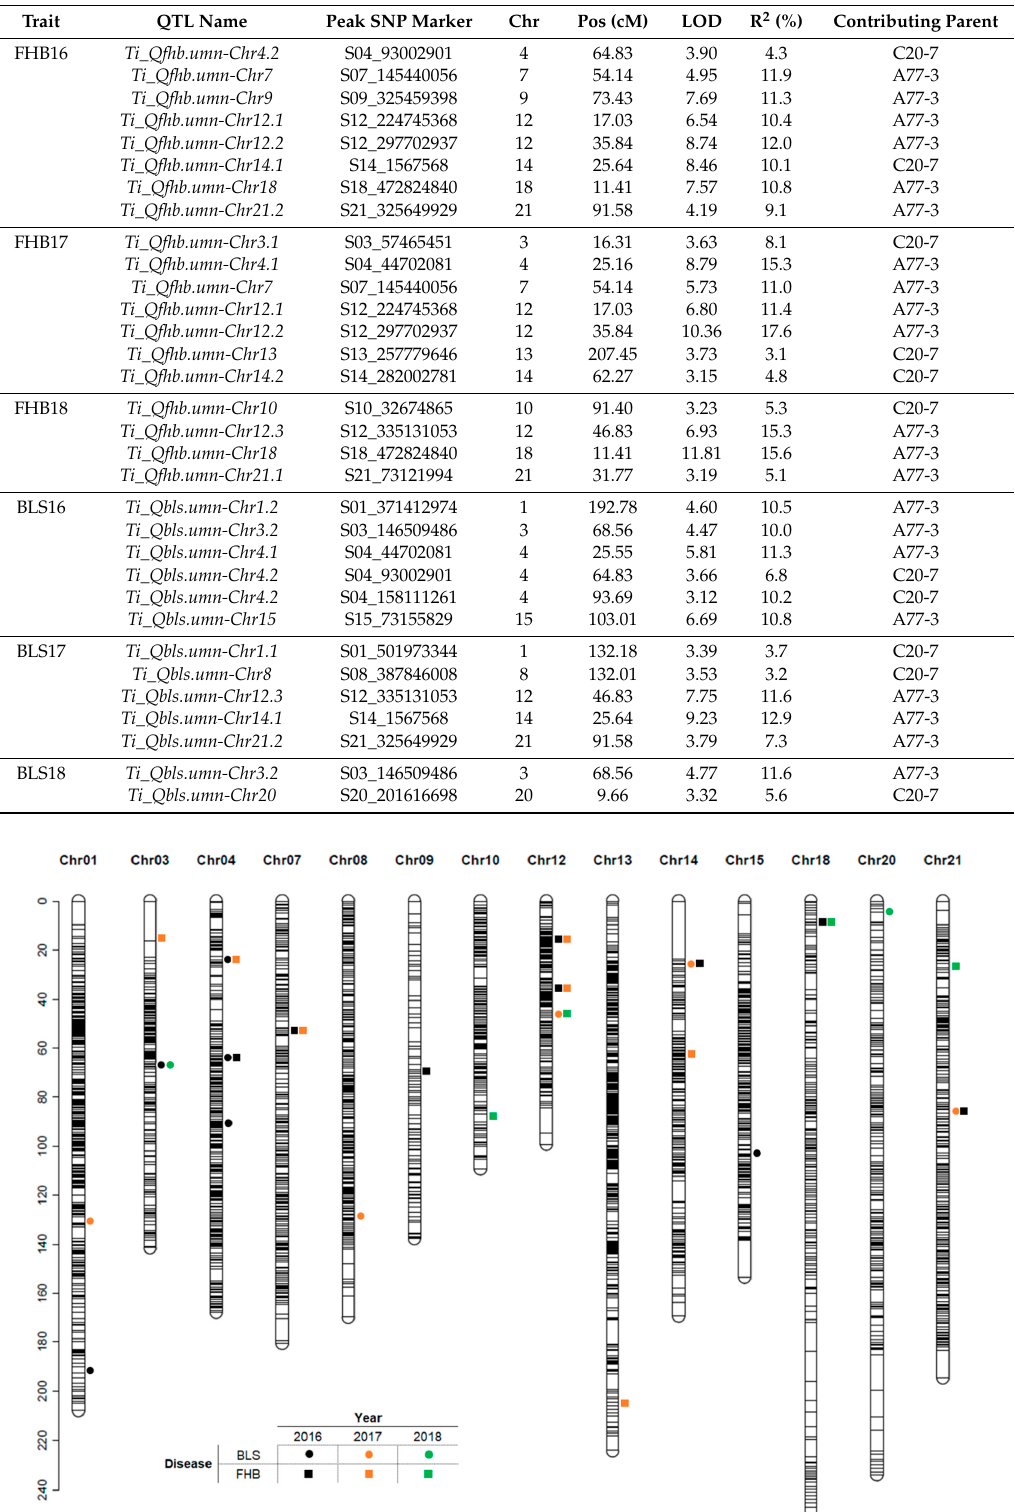
Table 3. Quantitative trait loci (QTL) for Fusarium head blight and bacterial leaf streak detected in the A77-3 × C20-7 IWG population.